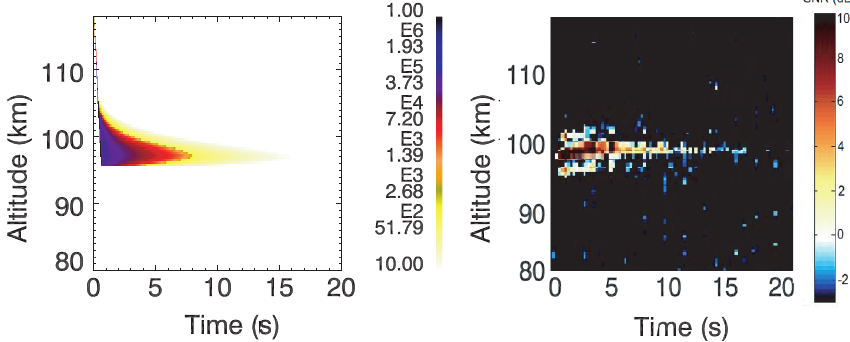
Fig. 1. In the left panel, a simulated head-echo and non-specular trail for a meteoroid entering at the time and geographic location of an observed meteor in North Carolina (35 ◦ N, 76 ◦ W) using the Univ. of Illinois radar operated at Fort Macon (right panel). The meteor was recorded near 00:00UT, on 27 June 2001. The simulated meteoroid mass is 20µg, traveling at a velocity of 55kms − 1 with a 45 ◦ entry angle, composed of an atomic mass of 30AMU (Chondritic type meteoroid). The duration of the trail turbulence is approximately 15s. The color bar on the left shows the instability growth rate in s − 1 for the trail, and the simulated head echo electron line density per meter divided by 10 6 (units chosen such that they appear on the same scale). The range-time-intensity (RTI) portion of the non-specular trail on the right side of the figure has the same altitude and time range as the simulation, with the color bar representing